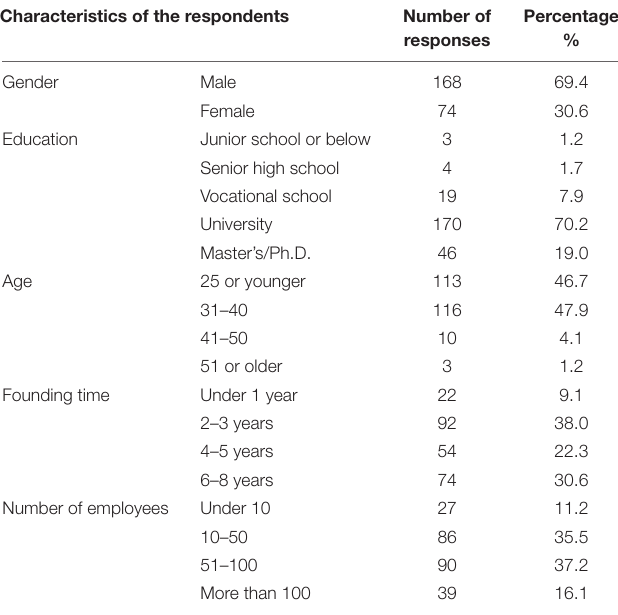
TABLE 1 | Characteristics of the respondents ( n =